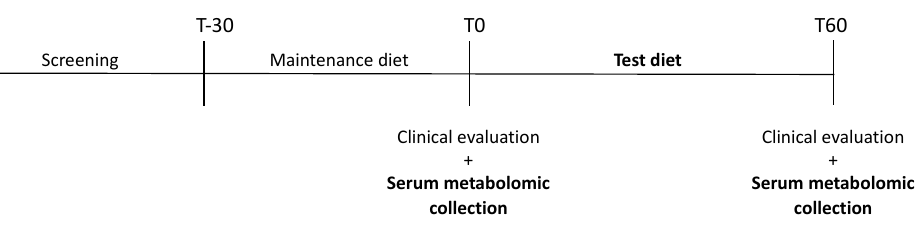
Figure 1. Visual scheme of the experimental schedule. Table 1. Diet composition per 100 kcal of dry matter (DM) and ingredients 1 according to the